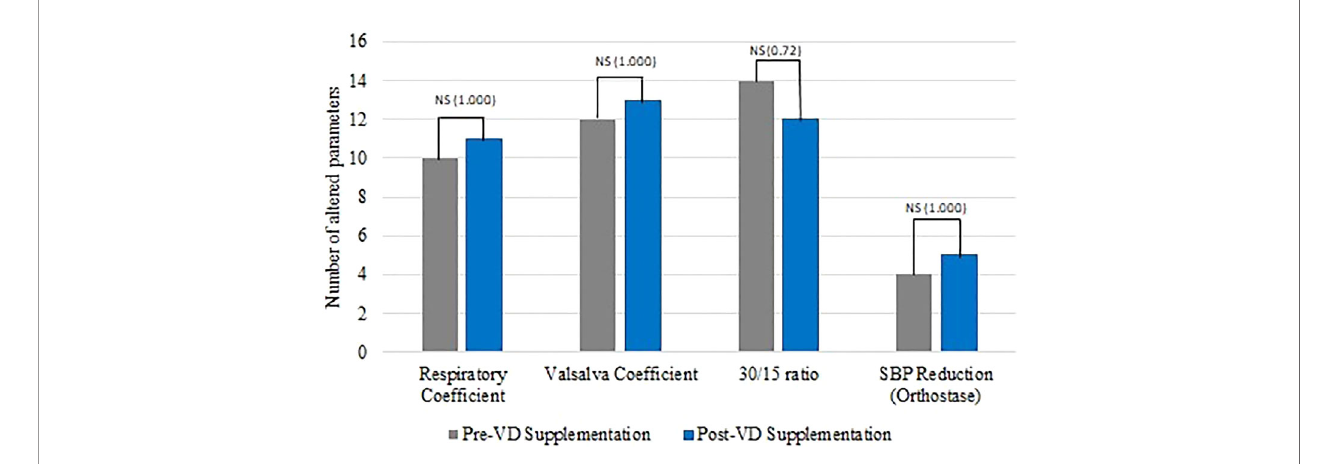
FIGURE 5 | Number of abnormal dynamic tests before and after VD supplementation.